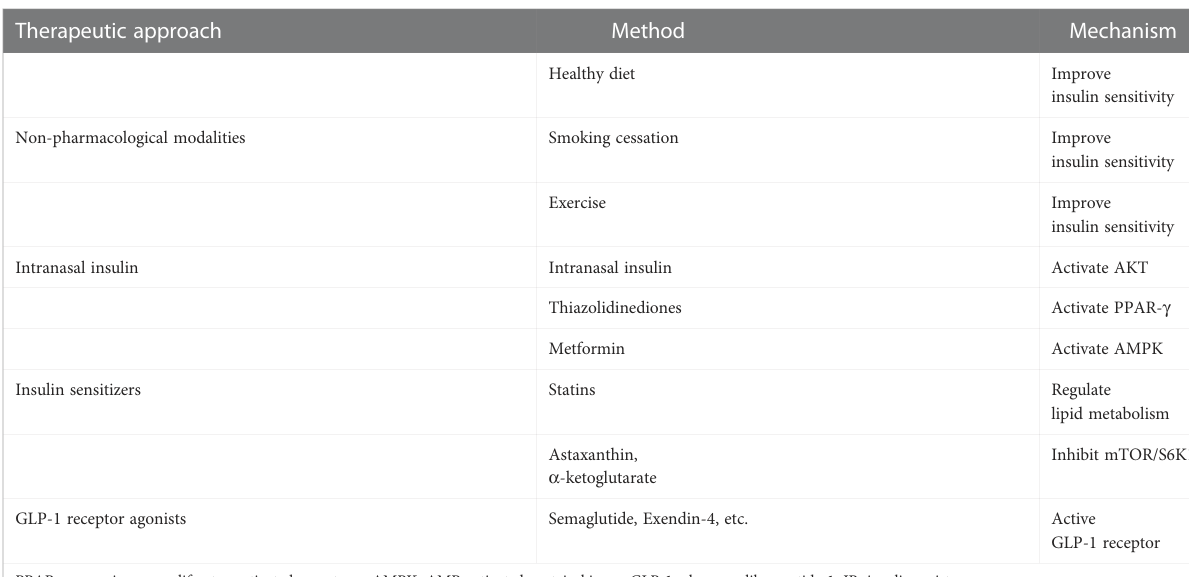
TABLE 2 The treatment of IR in ischemic